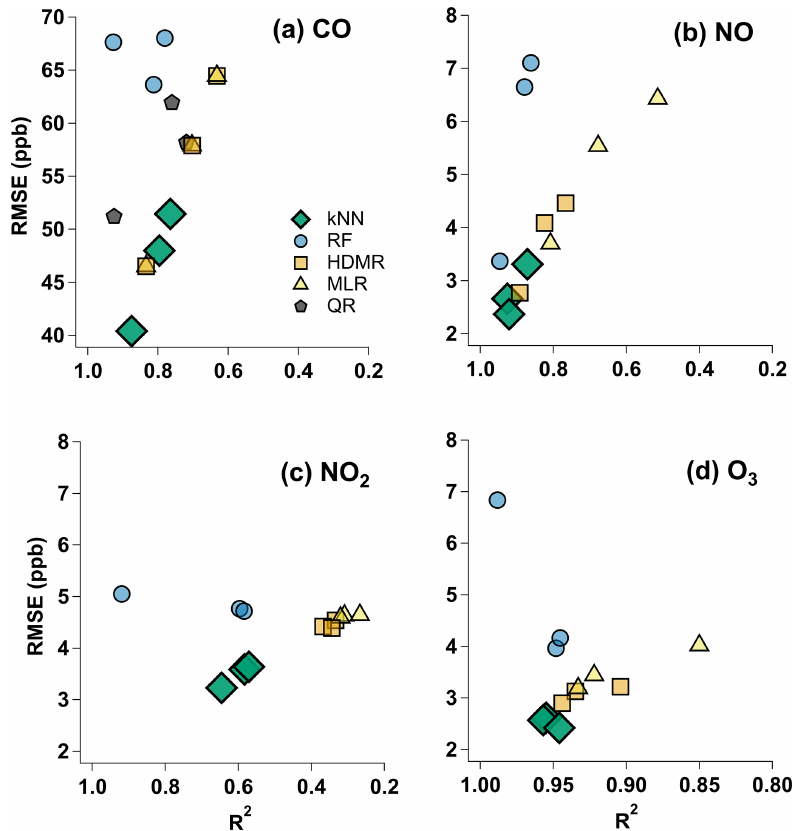
Figure 2. Performance comparison of gas sensors (a) CO, (b) NO, (c) NO 2 , and (d) O 3 as calibrated by the five types of modeling approaches adopted for this study ( k NN hybrid, RF hybrid, HDMR, MLR, QR). The model type is indicated by color and marker shape. An individual data point represents the paired metrics (RMSE and R 2 ) for one ARISense monitor. Since there are three ARISense (ARI013, ARI014, ARI015) monitors, there are three markers for each gas sensor–model combination. RMSE is root-mean-square error. R 2 is the coefficient of determination (negative infinity ≤ R 2 ≤ 1). The lower-left corner region of each panel indicates the highest performance based on these